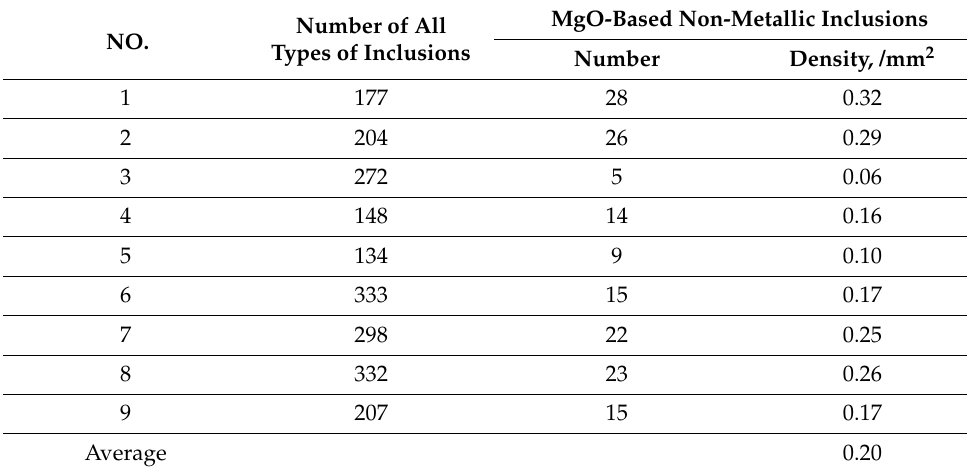
Table 3. Non-metallic inclusions in billet before improvement.